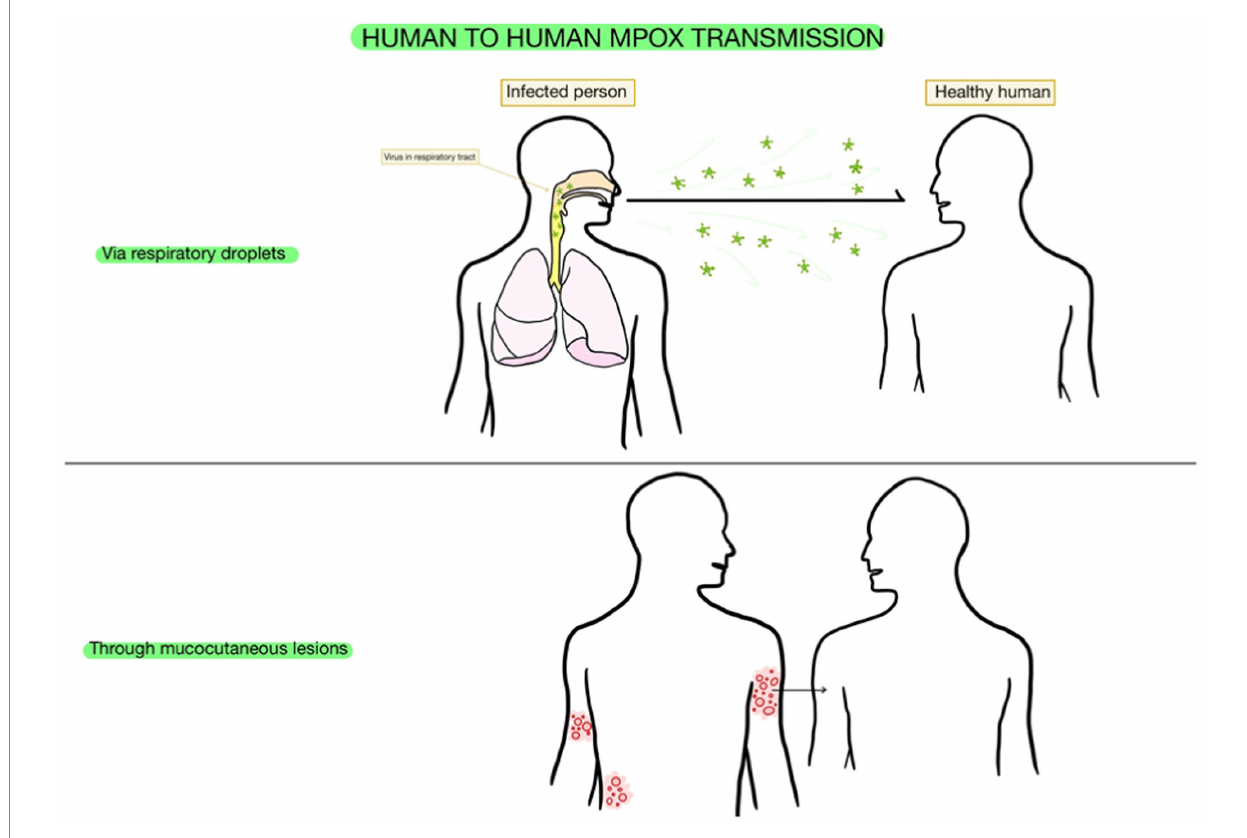
FIGURE 2 Transmission of mpox. This figure was created with GoodNotes and adapted from Wang et al.